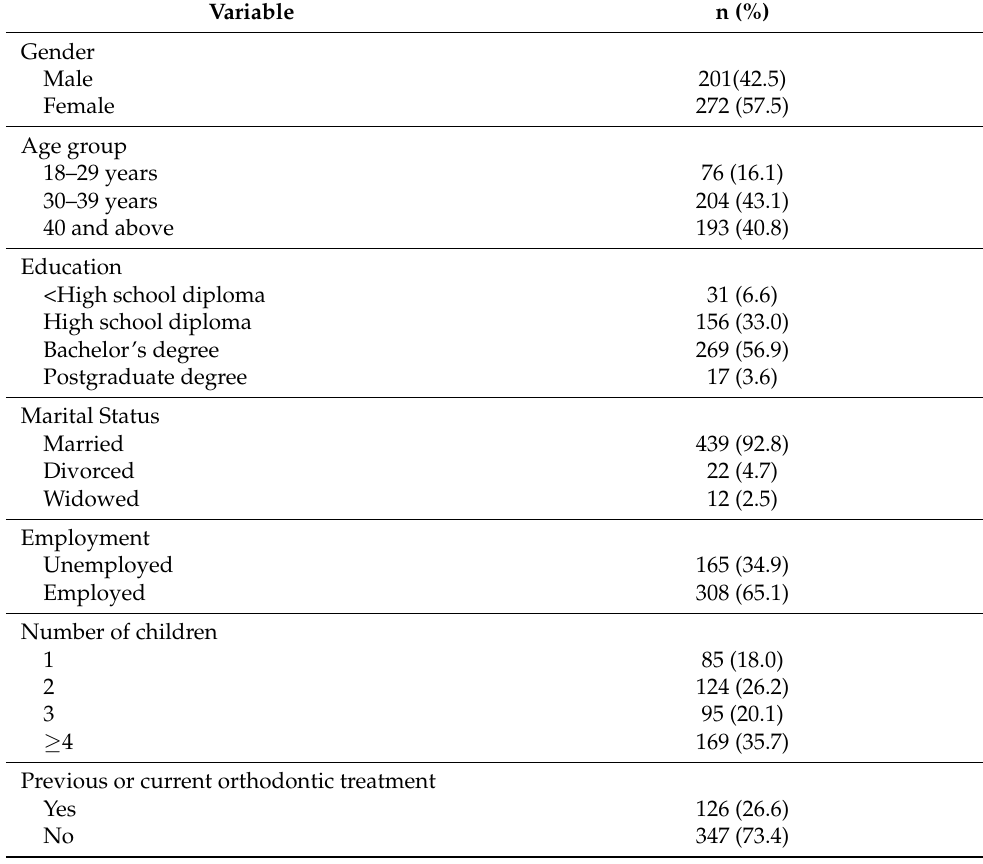
Table 1. Demographics of survey participants (N = 473).